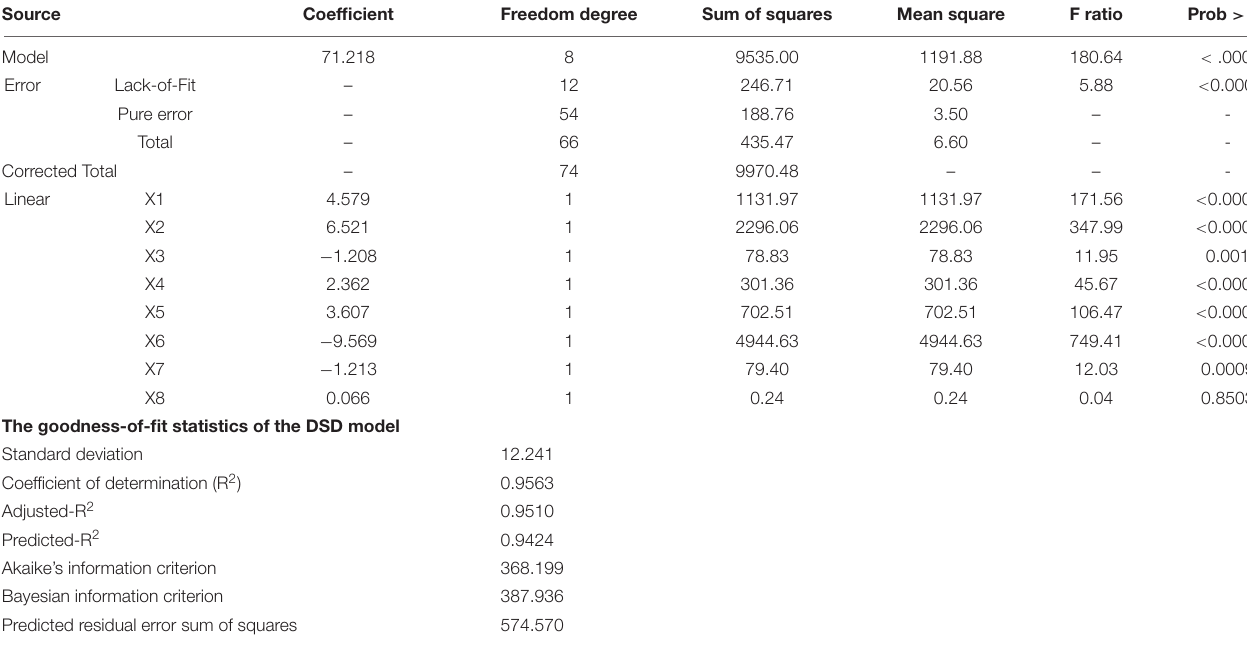
FIGURE 1 | The relative importance of each of the tested independent variables on the bioremoval of cobalt by P. alcaliphila. X1, pH; X2, incubation time (h); X3, initial CoSO TABLE 2 | Regression coefficient (coded units) and analysis of variance of the DSD experimental Co (II) bioremoval data by P. alcaliphila